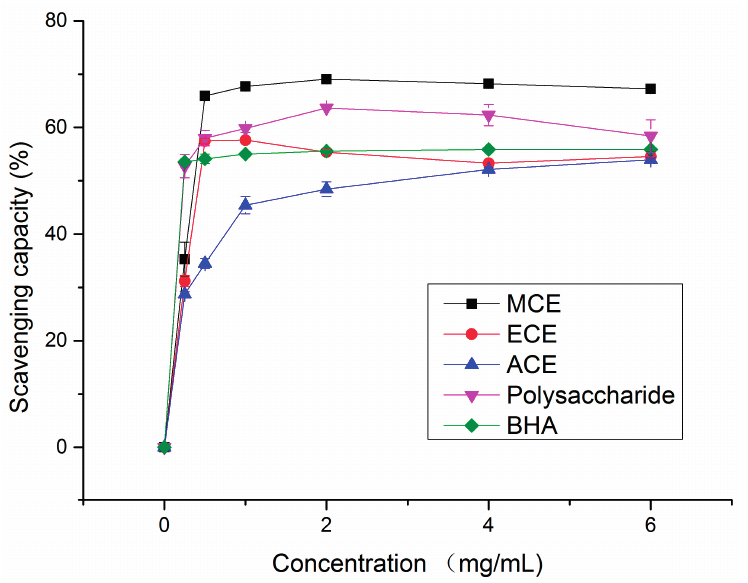
Figure 1. Free radical scavenging capacity of different concentrations of various extracts and BHA on 1,1-diphenyl-2-picrylhydrazyl radicals. MCE: methanolic